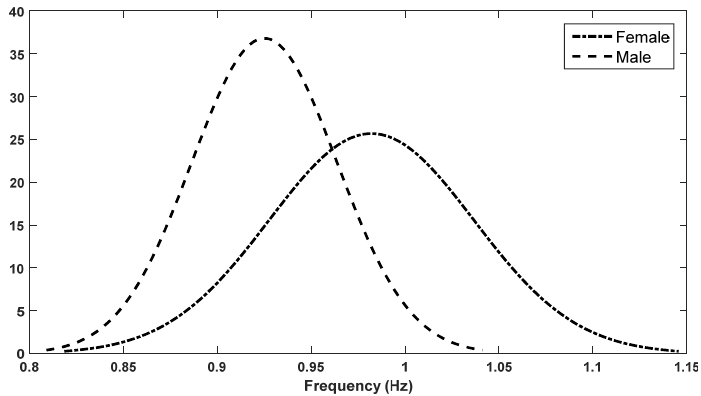
Figure 10. Distribution of fundamental frequencies (stride frequencies) of female and male subjects.